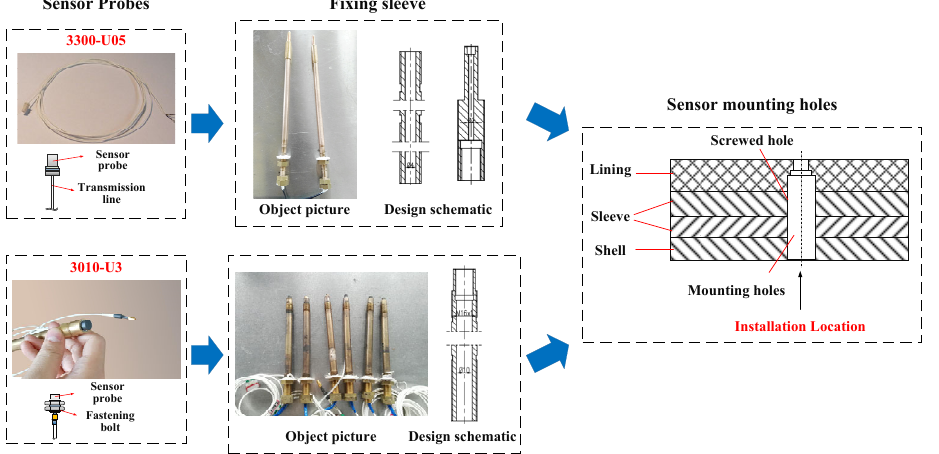
Table 2. Sensor parameters.